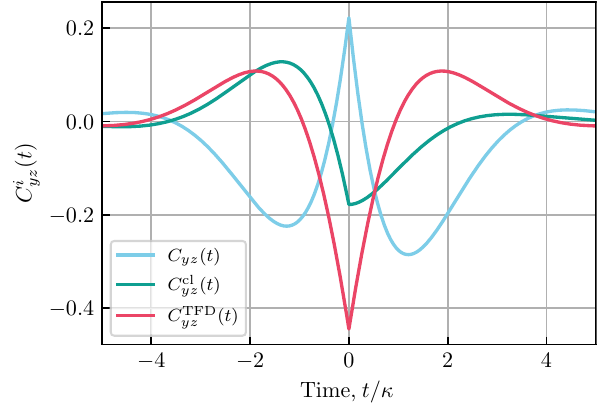
FIG. 3. Correlation functions and hidden TRS in a driven qubit. Stationary, connected (cid:5) σ y ( t )σ z ( 0 ) (cid:6) correlation functions for the dissipative Rabi-driven qubit system in Eq. (30), for a drive (cid:11) equal to the decay rate κ . Blue: the standard